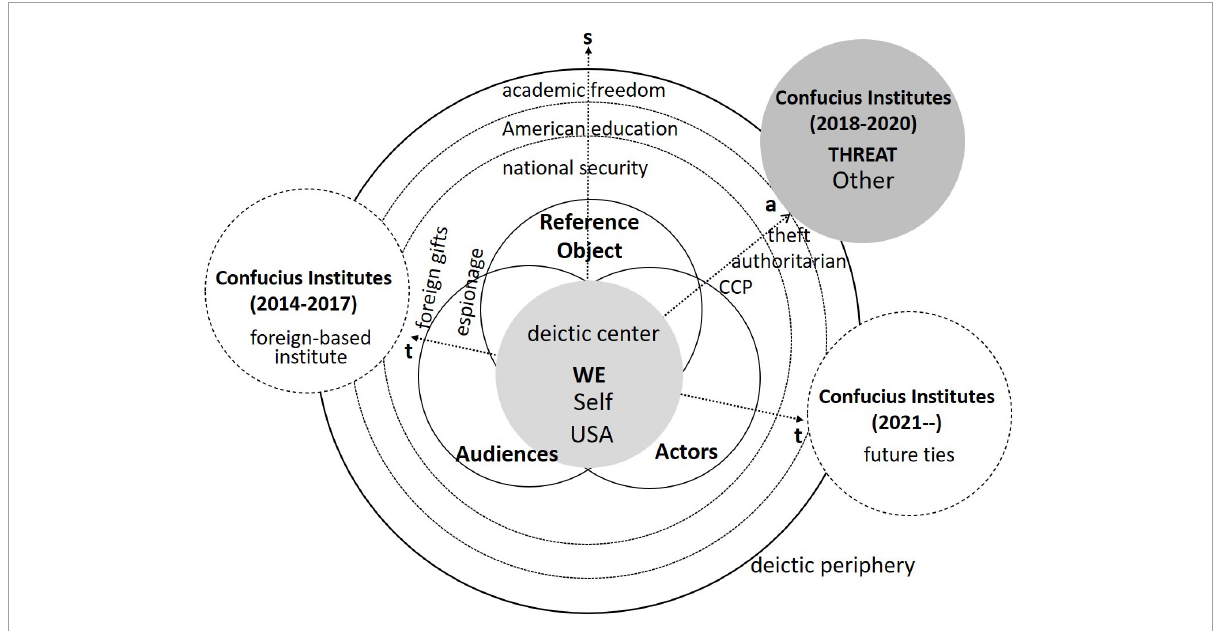
FIGURE4 The security discourse of Confucius